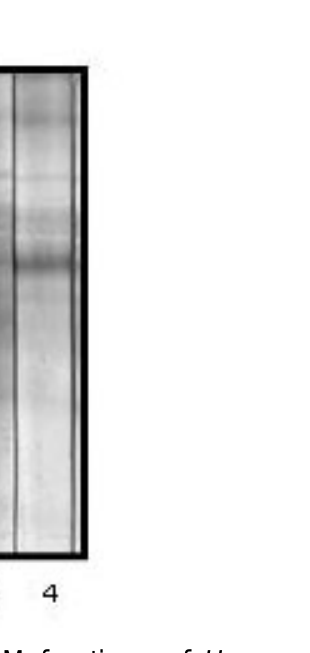
Figure 3. Antibody recognition of the H and M fractions of H. capsulatum antigen. Acute pulmonar histoplasmosis patient sera, concentrated to 10-fold, was evaluated by immunoblotting assay. Lane 1: patient serum before treatment; lane 2: patient serum during treatment; lane 3: patient serum 30 days after antimycotic therapy; lane 4: histoplasmosis control